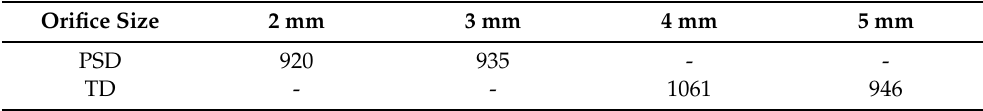
Table 3. Wave speeds (in ms − 1 ) estimated from the dominating frequency in a power spectral density (PSD) or the time delay (TD) between measurement points.